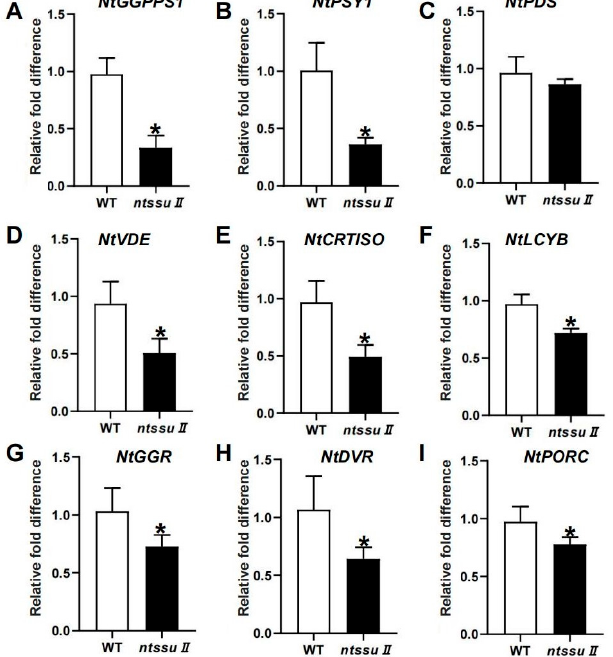
Figure 7. Relative expression of genes involved in carotenoid and chlorophyll biosynthesis. ( A – F ) The relative mRNA level of genes related to carotenoid biosynthesis, including NtGGPPS1 , NtPSY1 , NtPDS , NtVDE , NtCRTISO , and NtLCYB in ntssu Ⅱ , using WT as control. ( G – I ) The expression of genes involved in chlorophyll biosynthesis, including NtGGR , NtDVR , and NtPORC . Asterisks represent statistically significant differences between WT and transgenic plants determined by Student’s t -test (* p <